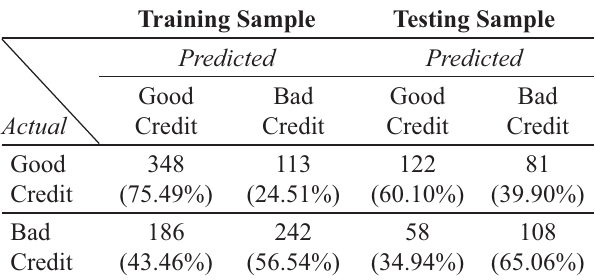
Table 2. Classifi cation results using logistic regression for training and testing samples